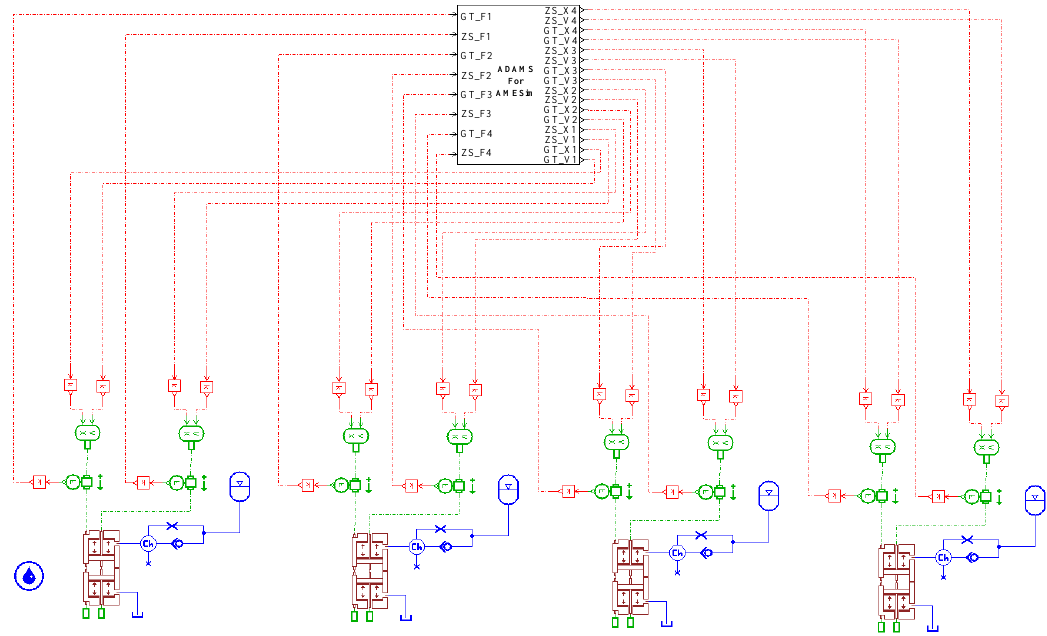
Figure 10. The combined simulation